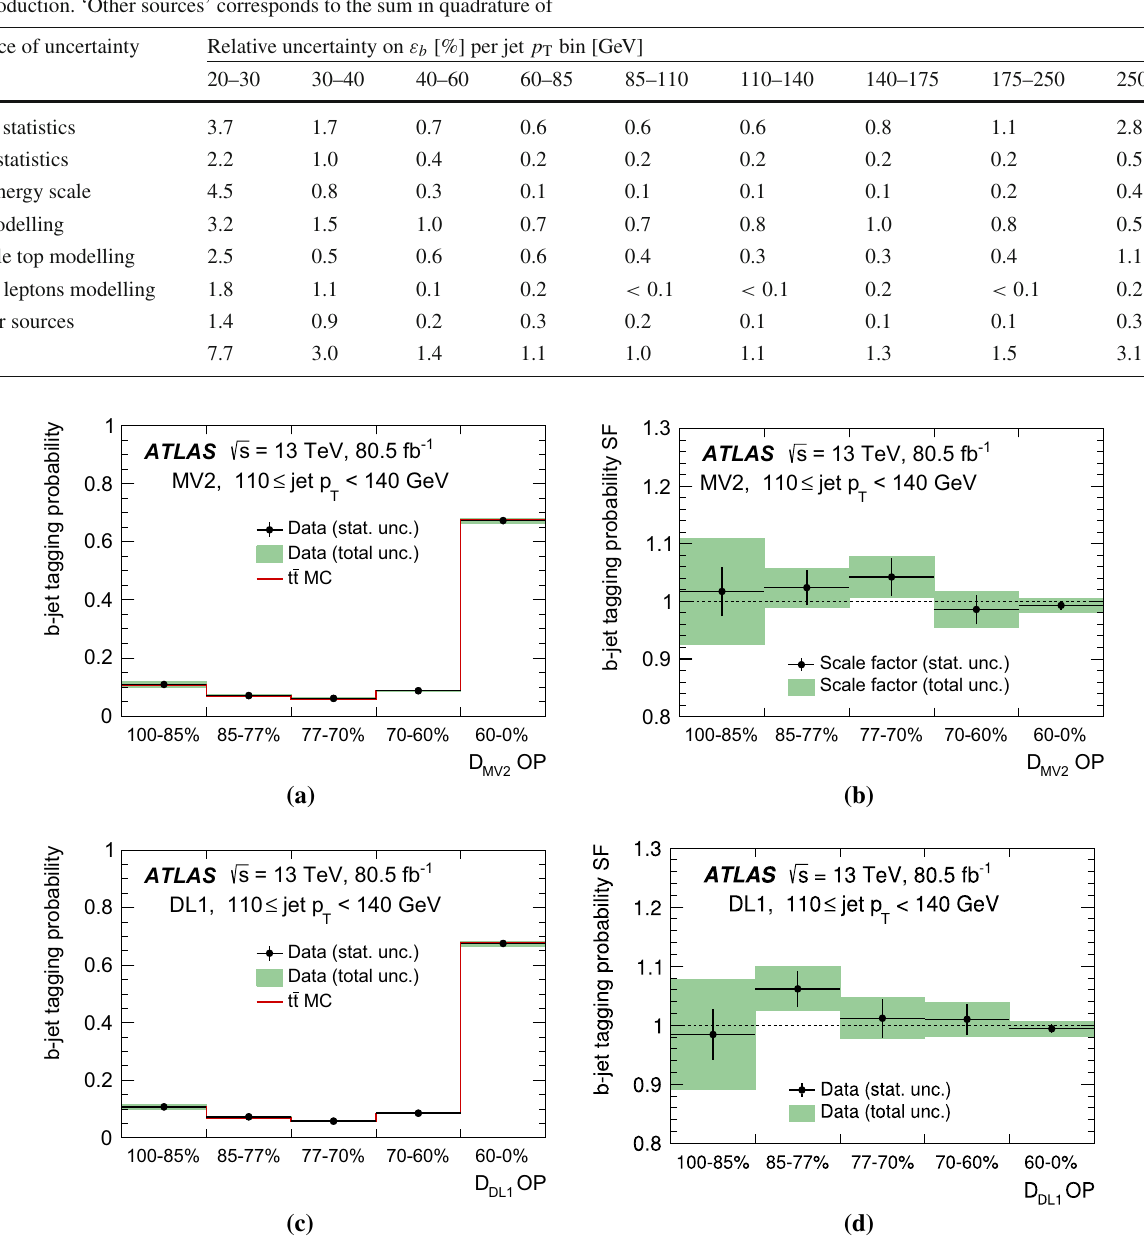
Fig. 11 The (a, c) b -jet tagging probability and (b, d) b -jet tagging probability simulation-to-data scale factors for the (a, b) MV2 and (c, d) DL1 tagger for jets with 110 ≤ p T < 140 GeV in the var- ious pseudo-continuous bins. The probability measurement is shown together with the probabilities derived from t ¯ t simulated events pass-